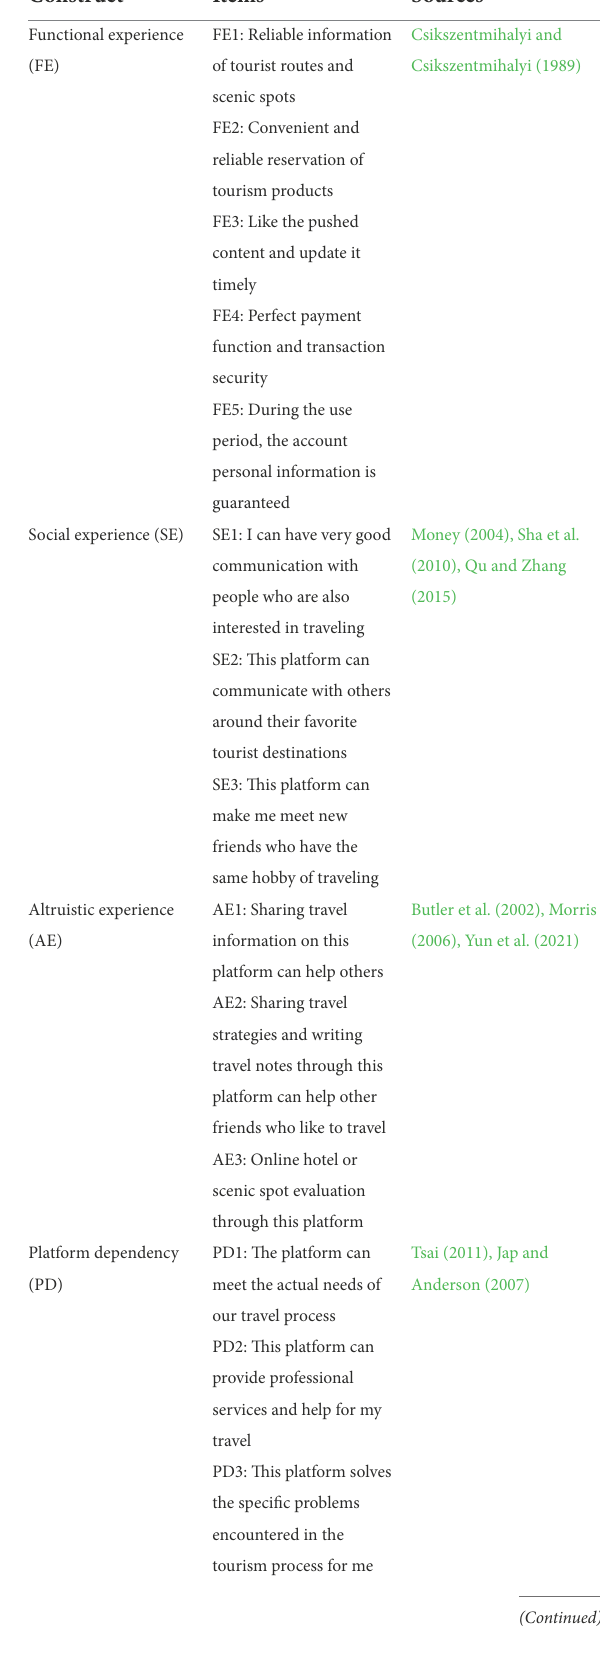
TABLE 1 Measurements of the